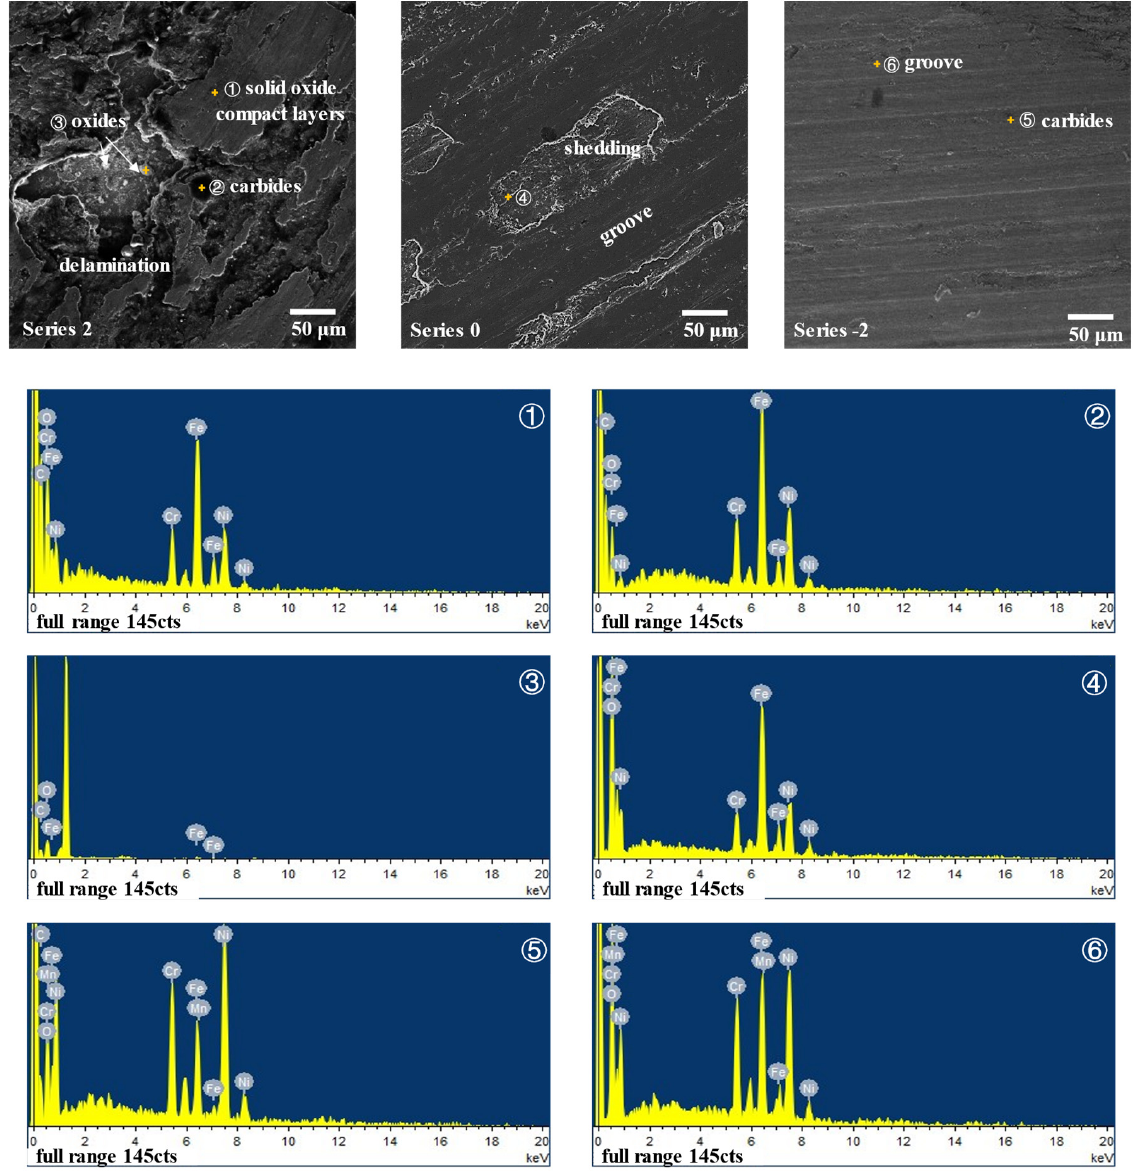
Figure 11. The typically worn surfaces of series 2, 0, and − 2 and the EDS analysis of feature points. Overall, the wear test results indicate that by changing the material of the last welded layers from Ni- to Fe-based material, the wear mechanism will change with the residual amount of Fe-based material. The wear resistance decreases when residual Fe-based ma- terial increases. However, when the residual thickness is less than 0.5 mm, the wear weight per minute is already at the same level as the sample without Fe-based material. It indicates that changing the last welded layers could be an economically feasible ap- proach to decrease the costs of the bimetallic layer surfacing method.